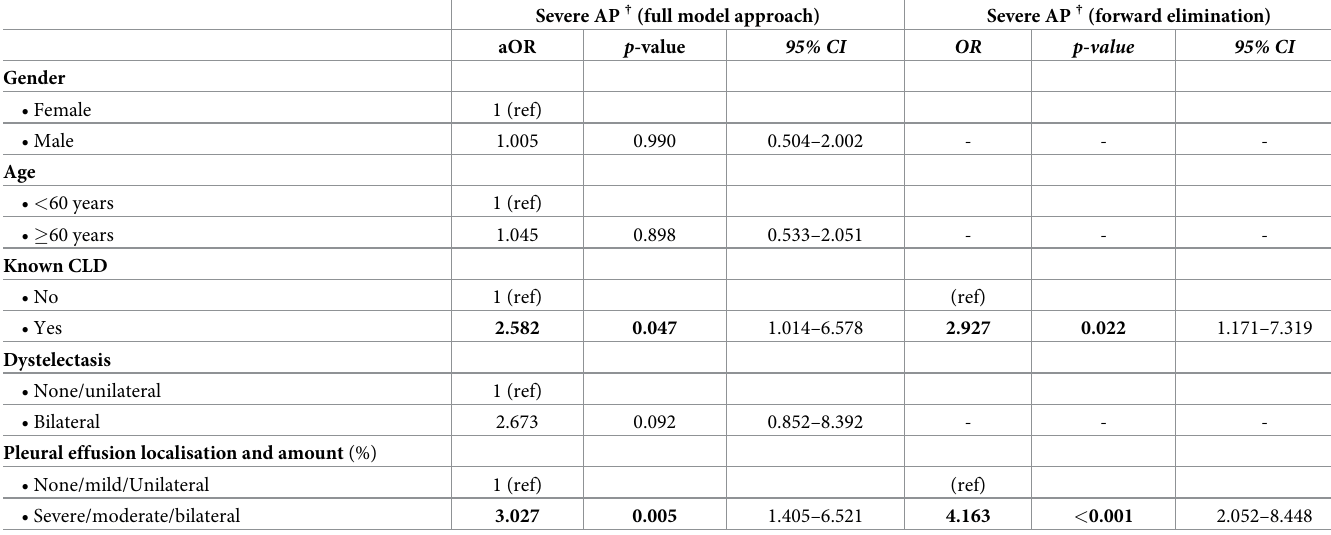
Table 3. Predictors of severe acute pancreatitis: Multivariable analysis (n = 358).